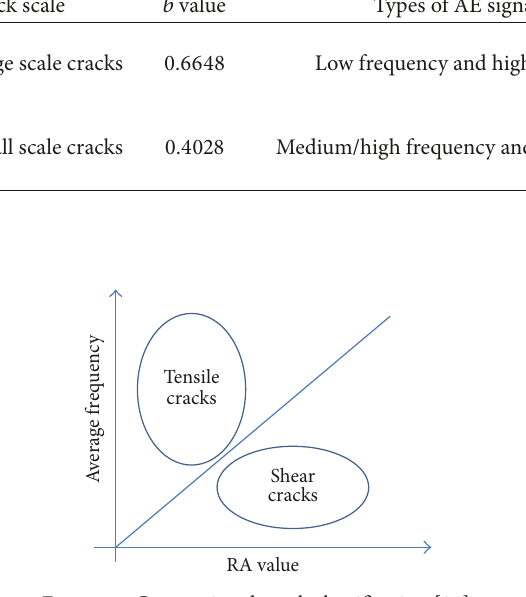
Figure 7: Conventional crack classification [27].